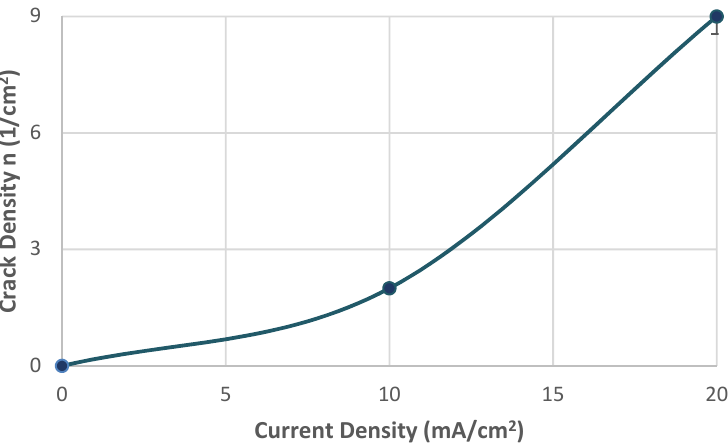
Figure 9. Correlation between surficial density of microcracks and applied current density during in situ hydrogen cathodic charging and slow strain rate bending loading.